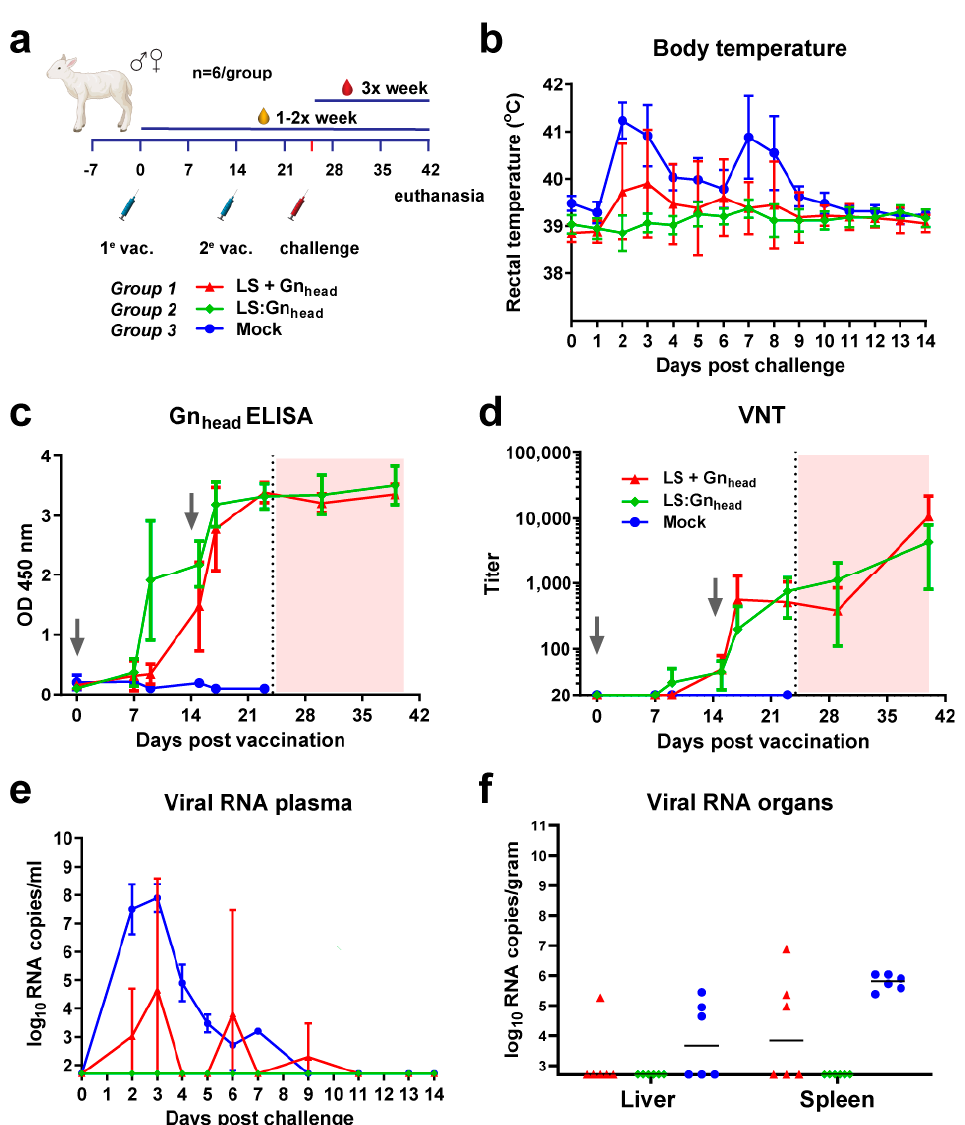
Figure 4. RVFV vaccination-challenge experiment with Gn head -conjugated LS particles in lambs. ( a ) Schematic presentation of the vaccination regimen and vaccines. ( b ) Average rectal temperatures of vaccinated and mock-vaccinated lambs post RVFV challenge. ( c ) Gn head -specific antibody responses as determined by ELISA. ( d ) Neutralizing antibody responses in weekly-obtained serum samples. The x-axis is set to the limit of detection of the VNT and wells were considered positive when >50% inhibition of viral growth was observed. ( e ) Monitoring of viral RNA in vaccinated and mock-vaccinated lambs using RT-qPCR. Samples that tested negative are depicted at the detection limit of the PCR (1.3 log 10 RNA copies/mL) ( f ) Viral RNA in liver and spleen samples of vaccinated and mock-vaccinated lambs using RT-qPCR. Samples that tested negative are depicted at the detection limit of the PCR (2.3 log 10 RNA copies/mL). No animals succumbed or reached a HEP in this experiment. Error bars in panels b, c, d and e represent SDs.